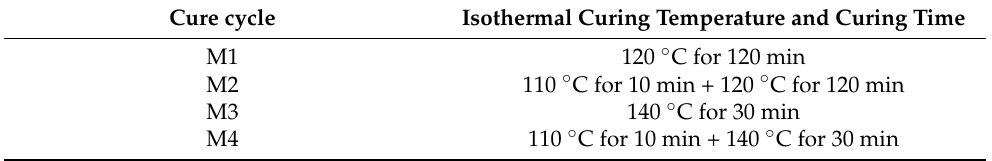
Table 1. Various microwave cure cycles of composite